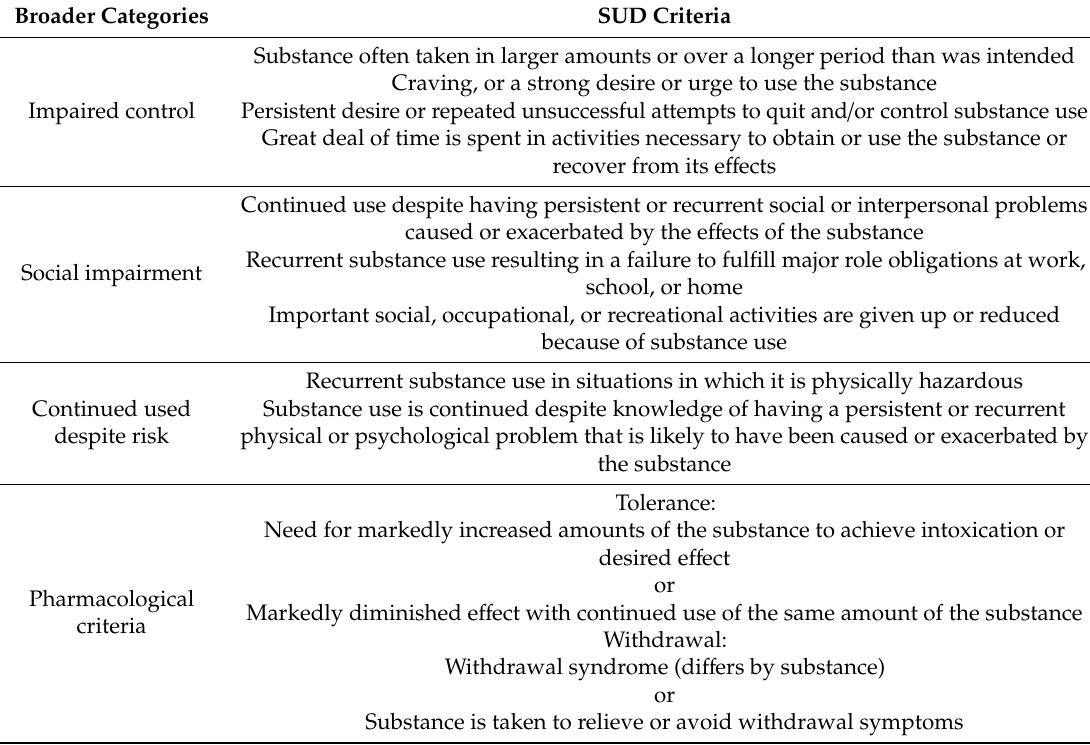
Table 1. Diagnostic and Statistical Manuel of Mental Disorders version 5 (DSM-5) diagnostic criteria of substance use disorder (SUD). A person needs to meet at least 2 of these criteria and have significant impairment or distress from his pattern of substance use to be diagnosed with a SUD. The severity of addiction is determined by the number of criteria met: 2–3 mild; 4–5 moderate; ≥ 6